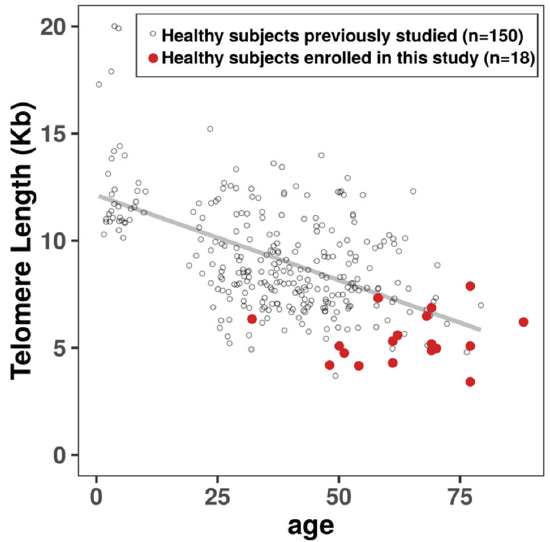
Figure 4. Telomere length in peripheral blood lymphocytes as a function of age. The healthy blood donors enrolled in this study presented very short telomeres in their peripheral blood lymphocytes compared to those of a previously studied cohort of 150 blood donors [34]. The regression line indicates natural telomere shortening with age (79 pb per year; Y = 12.1–0.79 and R2 = 0.29). Telomere length was measured by Q-FISH. Fluorescence intensity was transformed to kilobases according to the correlation between Q-FISH and Southern Blot results.